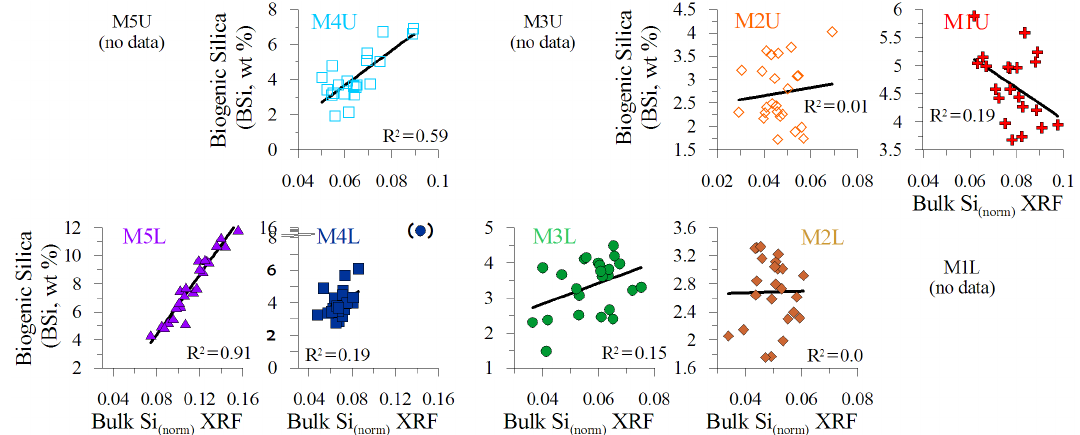
Figure 8. Biogenic silica versus total silica in particulate fluxes at five sites across the North Atlantic with sampling site M1 in the east (right) and M5 in the west (left).